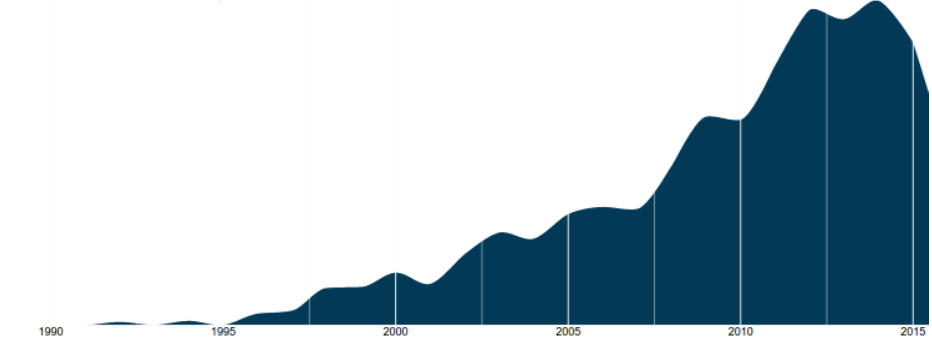
Figure 1: Volume of academic papers per year dealing with digital rights contention between 1993 and 2015.